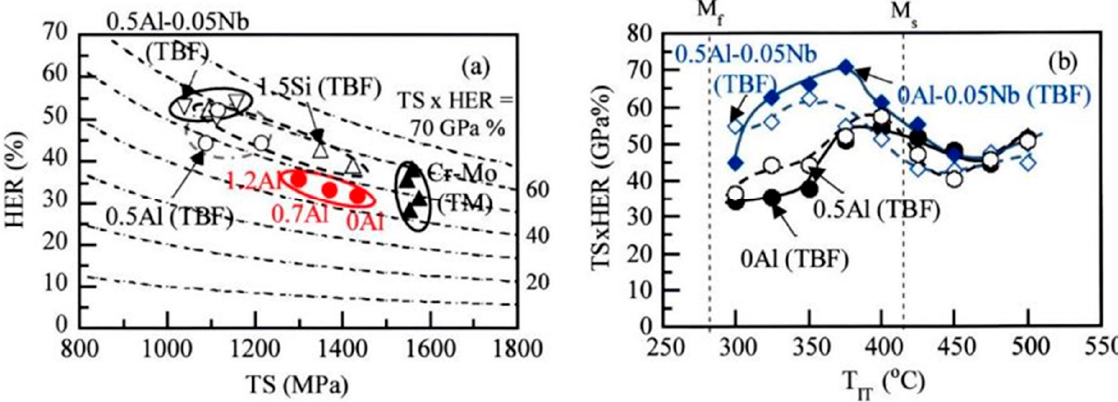
Figure 15. ( a ) Relationship between hole-expansion ratio (HER) and tensile strength (TS) in 0.20C- 1.50Si-1.24Mn-0.20Cr-0.022Al-0.0028 (0Al), 0.20C-0.73Si-1.24Mn-0.19Cr-0.72Al-9.0027B (0.7Al), and 0.20C-0.20Si-1.24Mn-0.20Cr-1.22Al-0.0026B (1.2Al) TM steels ( ● ) [55,88], 0.2C-1.5Si-1.5Mn-(0-1.0)Cr-(0-0.2)Mo (Cr-Mo) TM steels ( ▲ ) [53], 0.20C-0.99Si-1.51Mn-0.49Al (0.5Al) TBF steel ( ○ ) [14], 0.20C-1.00Si-1.50Mn-0.48Al-0.049Nb (0.5Al-0.05Nb) TBF steel ( ▽ ) [14], and 0.2C-1.5Si-1.5Mn-0.05Nb (1.5Si) TBF steel ( △ ) [51]. ( b ) Variations in the product of TS and HER (TS × HER) as a function